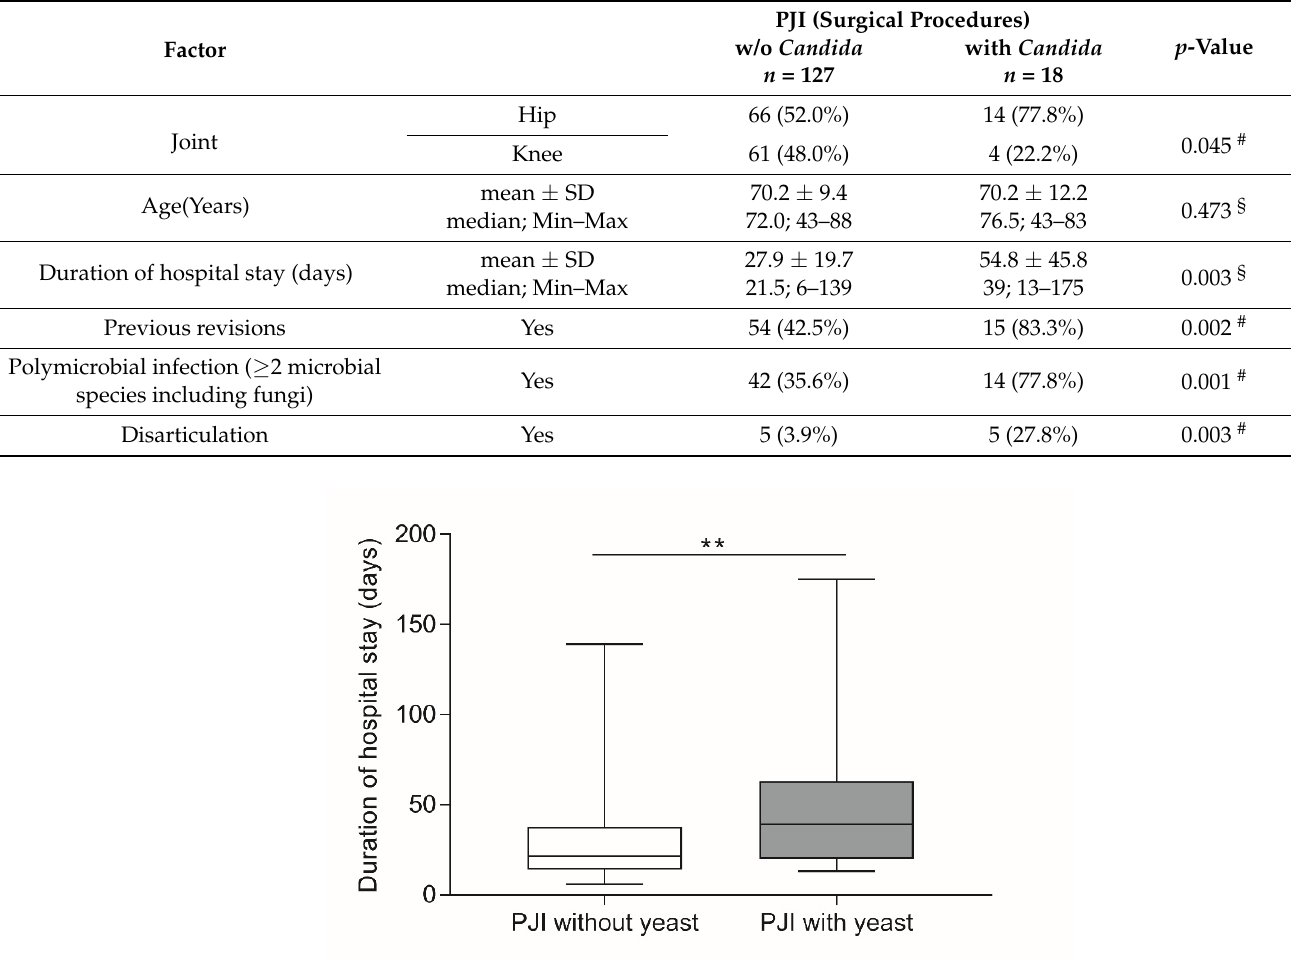
Table 3. Overview of patient and microbial factors in PJI without and with detection of a Candida species . § Mann–Whitney U test; # Fisher’s exact test.